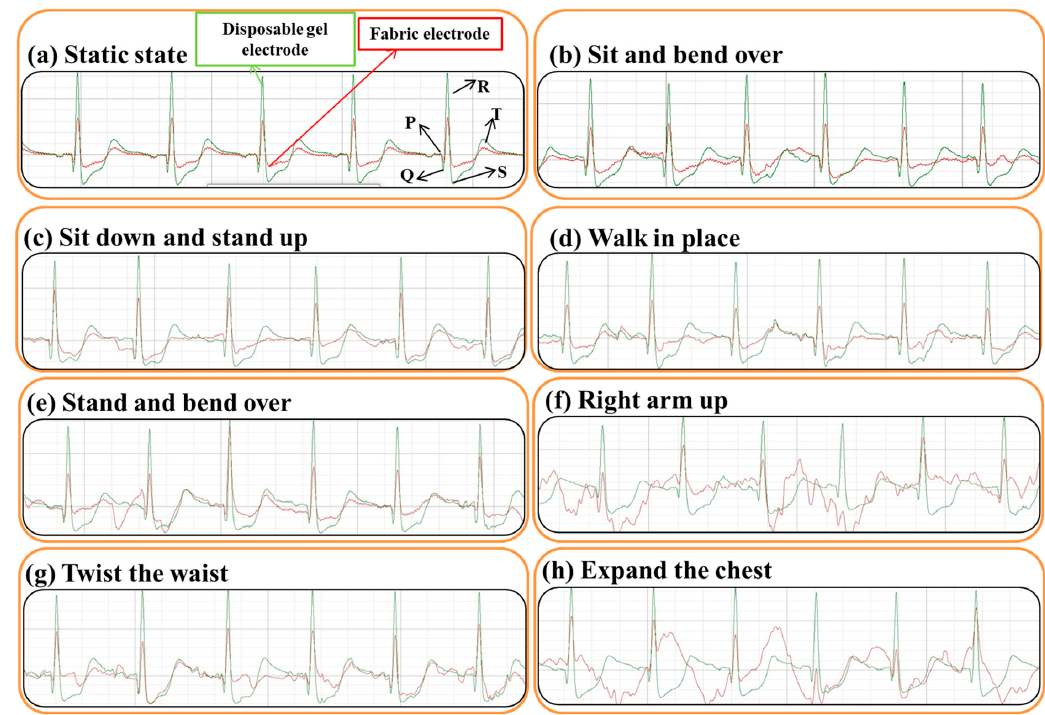
Figure 10. Corduroy fabric electrodes and disposable gel electrodes monitor ECG in different states of the human body.